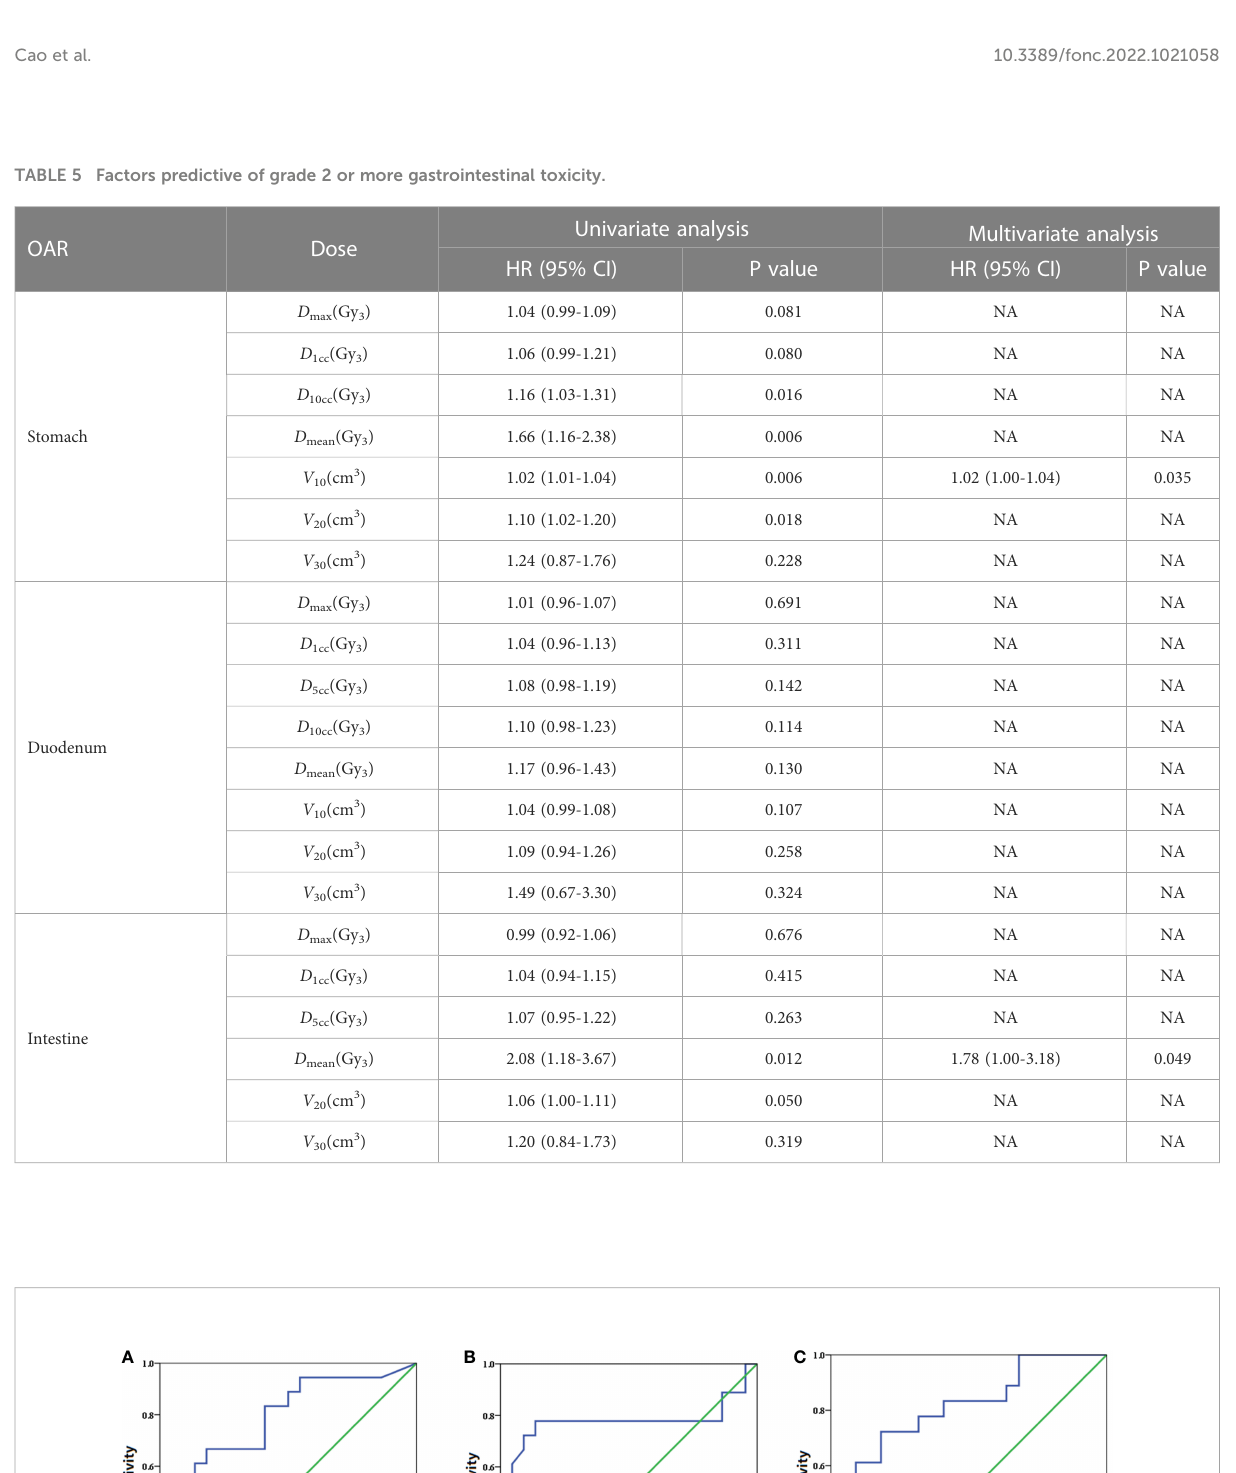
TABLE 5 Factors predictive of grade 2 or more gastrointestinal toxicity.